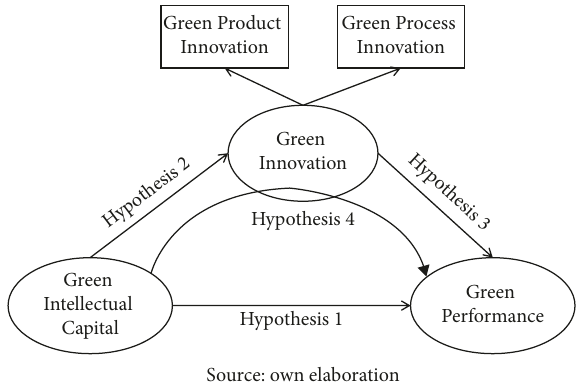
Figure 1: Proposed theoretical model. Source: own